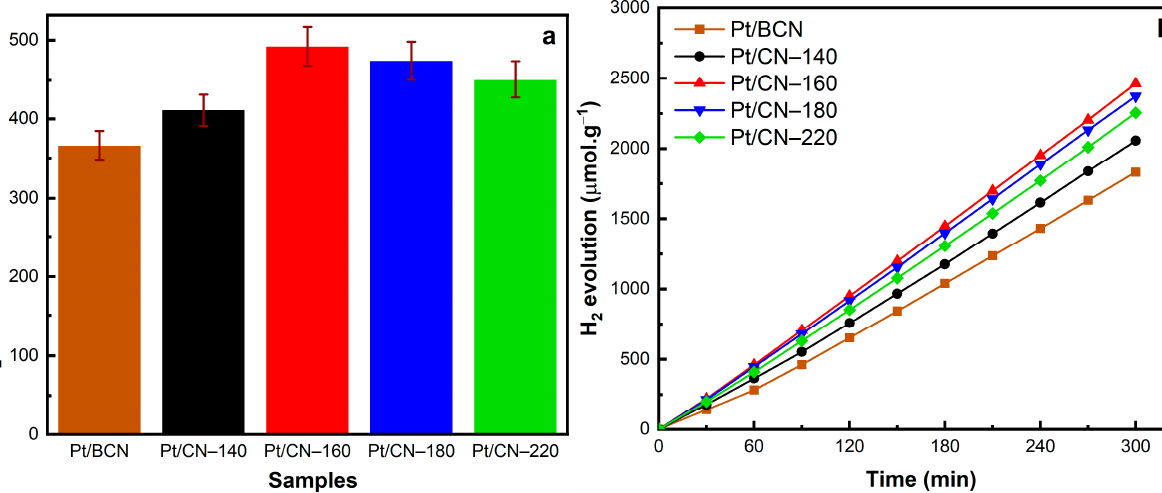
Figure S2: SEM images of (a) Pt/CN-140, (b) Pt/CN-160, (c) Pt/CN-180, and (d) Pt/CN-220 photocata- lysts and the corresponding EDS elemental mappings of C, and N, Figure S3: XPS survey spectra of Pt/CN photocatalysts.